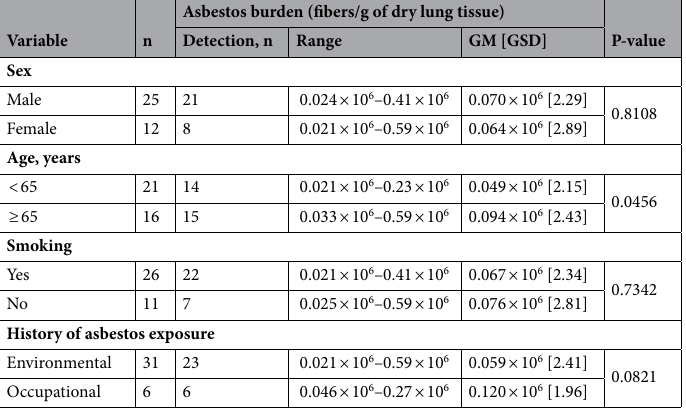
Variable Asbestos burden (fibers/g of dry lung tissue)